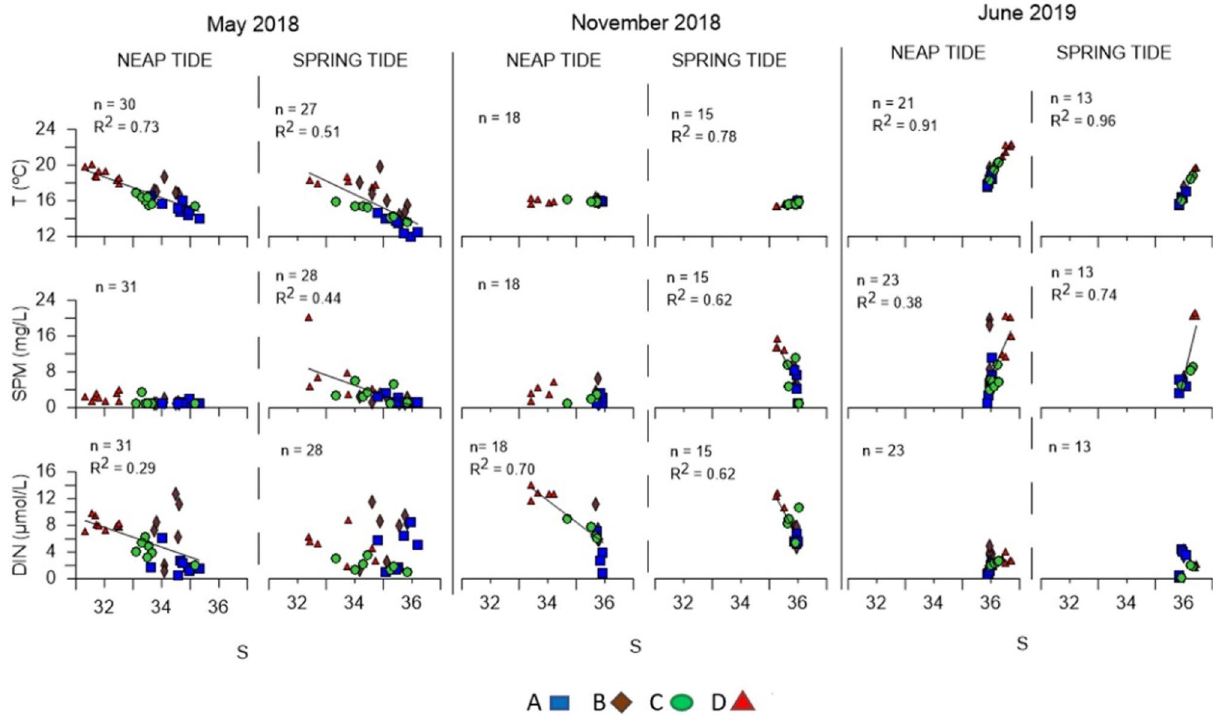
Figure 6. Relationships between temperature (T), suspended particulate matter (SPM) and dissolved inorganic nitrogen (DIN) with salinity, observed during the sampling campaigns in neap tide and spring tide conditions. Data collected at the surface. Only R 2 > 0.2 and the respective lines are presented. The figure was produced using